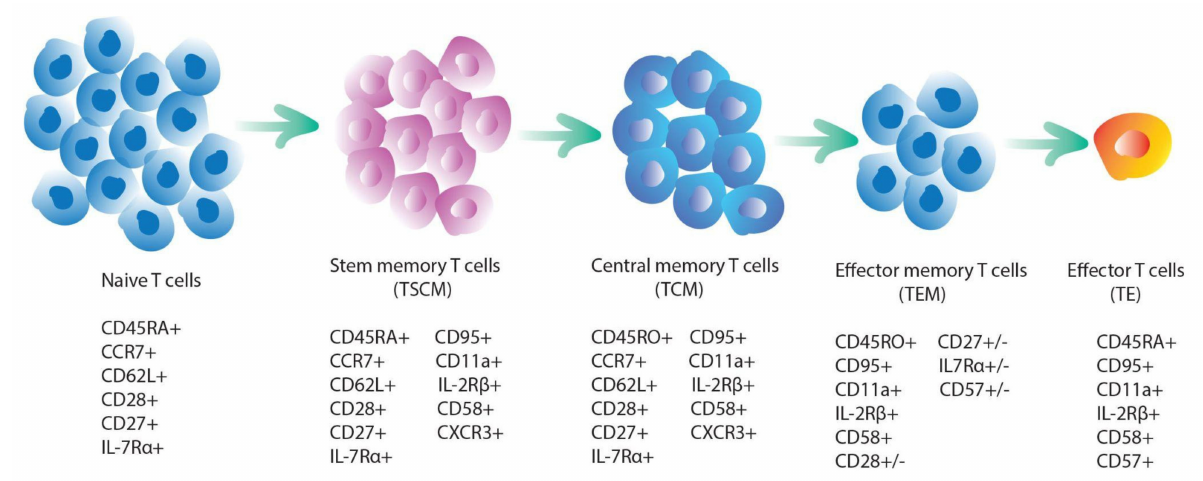
Figure 3. A model of T-cell differentiation and markers of T-cell